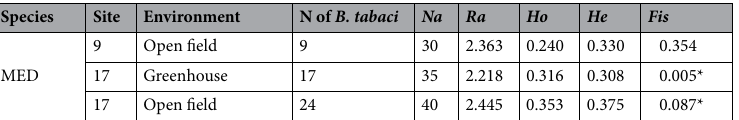
Table 2. Population genetic diversity indices. Species of whiteflies, site number where individuals were collected (as referred to in Table 1), number of individual genotyped (N), mean number of alleles per population (Na), allelic richness (Ra), observed heterozygosity (Ho), expected heterozygosity (He), and fixation indices (Fis) presented together with Bonferroni corrected p value from Hardy–Weinberg equilibrium